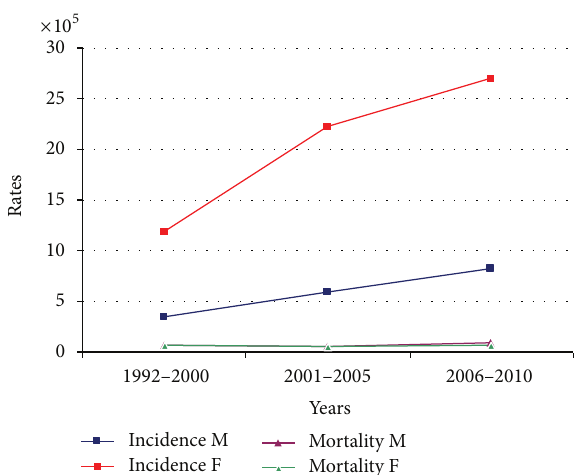
Figure 1: Incidence and mortality rates trends.